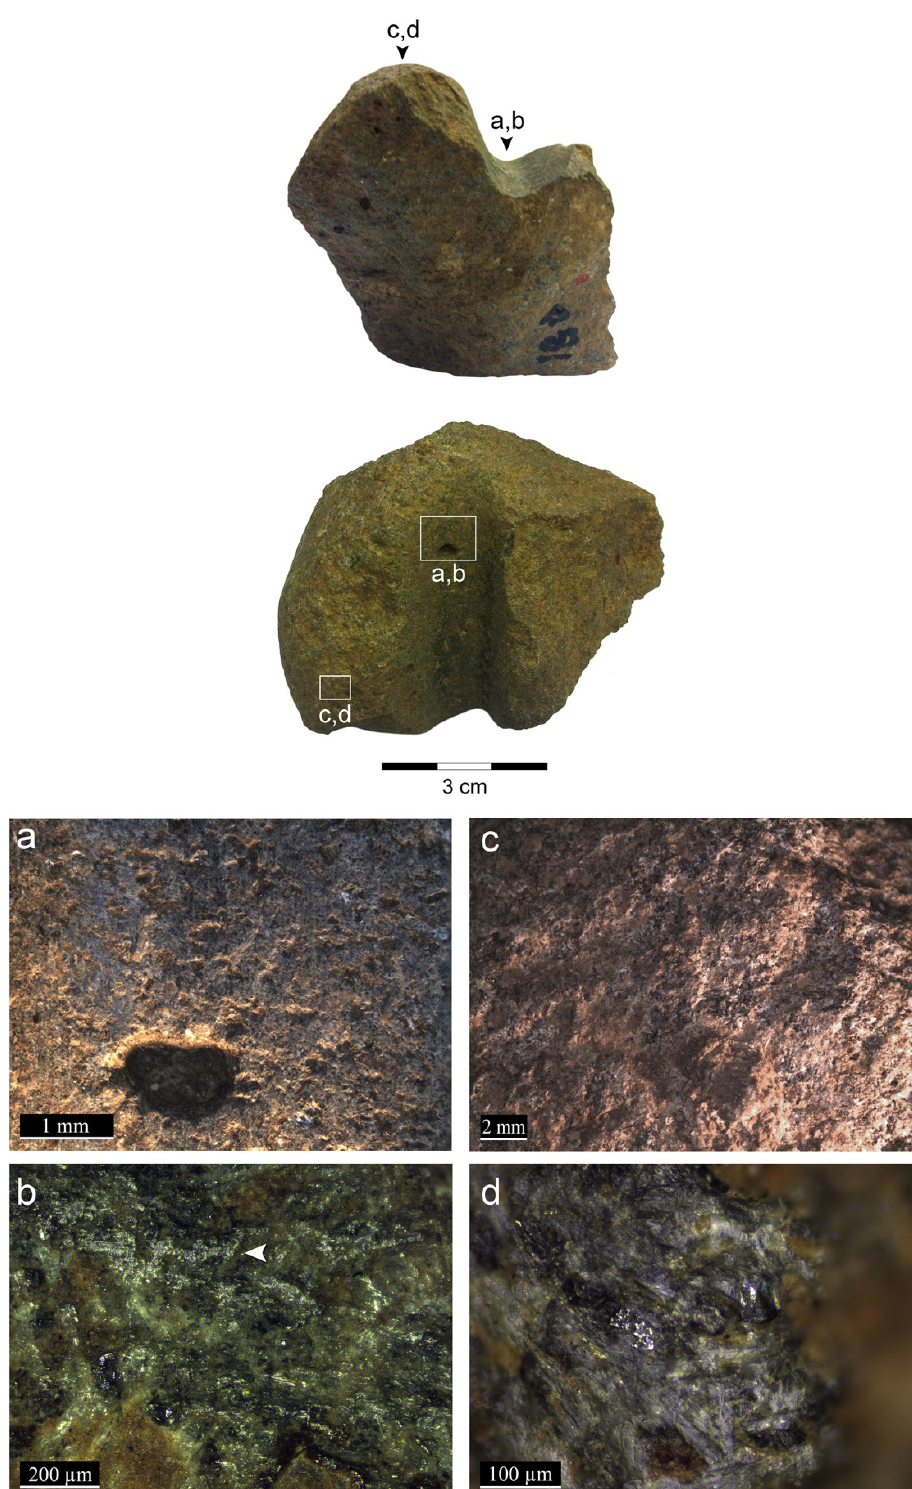
Figure 7: Artefact number 180 is a fragment of a pestle on which a groove was shaped. The groove has a concave bottom with walls extending outward. Locations of microphotographs are indicated by arrows. Traces inside the groove are interpreted as having been produced by contact with a medium hardness material such as bone, wood or reeds: a) slight blackening on the bottom of the groove, extremely flat and smooth surfaces associated with lower areas (x6.7), b) translucent, bright and granular polish indicated by the white arrow, exhibiting directionality pattern parallel to the main axis of the groove (x100). Traces on the perimeters interpreted as having been produced by contact with a hard stone: c) levelled rough surface indicating short duration abrasion (x6.7), d) translucent, thin and dull polish extending on a wide surface